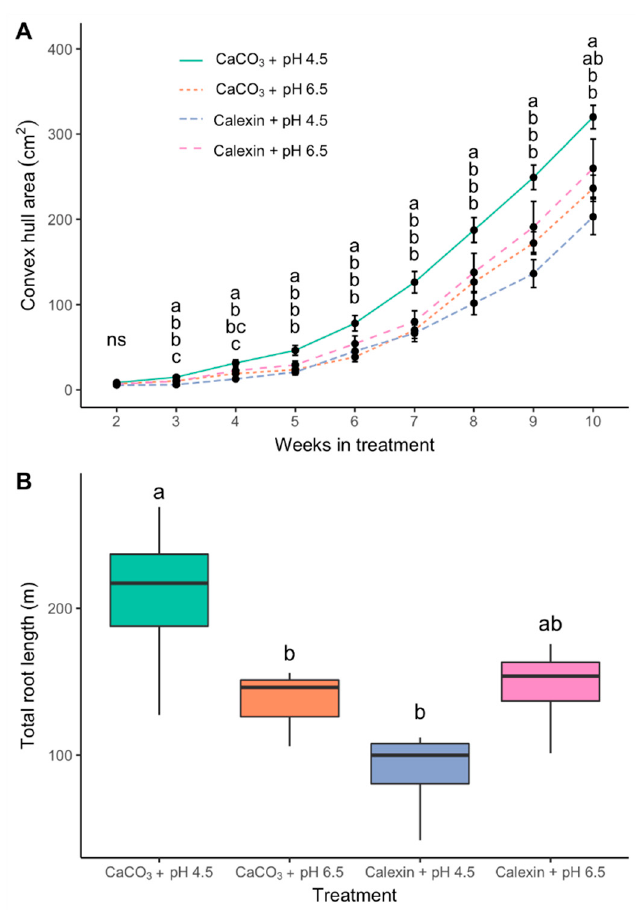
Figure 2. Root system characteristics of ‘Emerald’ southern highbush blueberry grown with contrasting substrate amendments and fertigation pH. ( A ) Convex hull area during the treatment period. ( B ) Total root length after 77 days of cultivation. Means followed by the same letter were not significantly different according to Tukey LSD at α = 0.05.